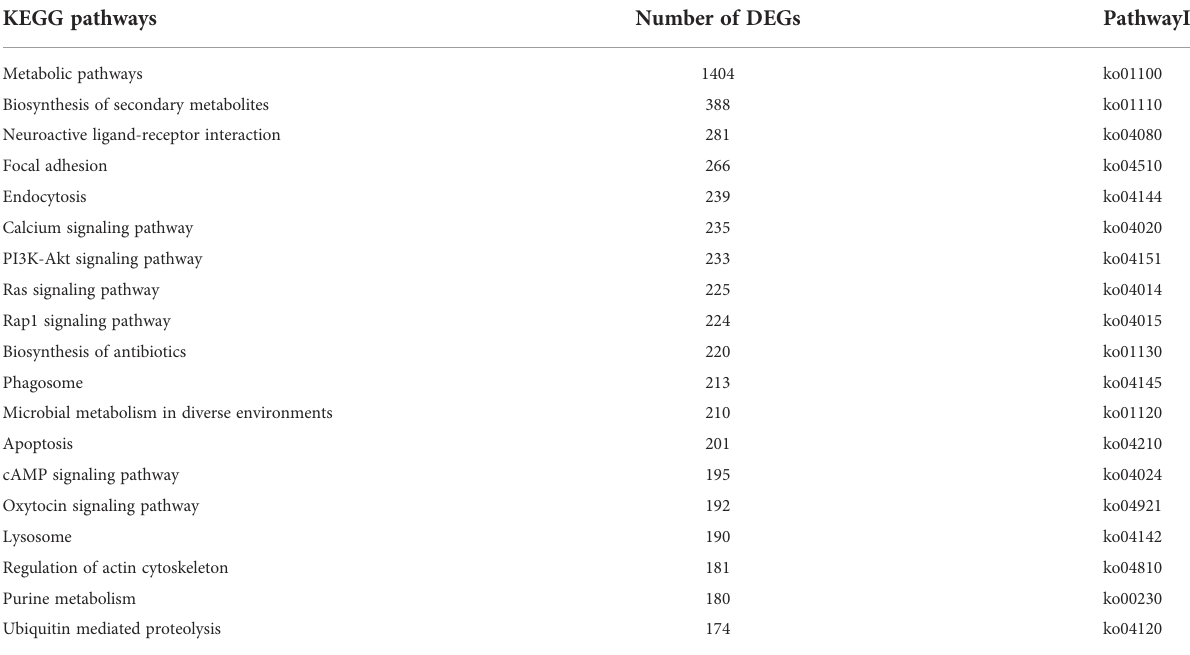
TABLE 3 Number of top 20 KEGG pathways and DEGs associated with